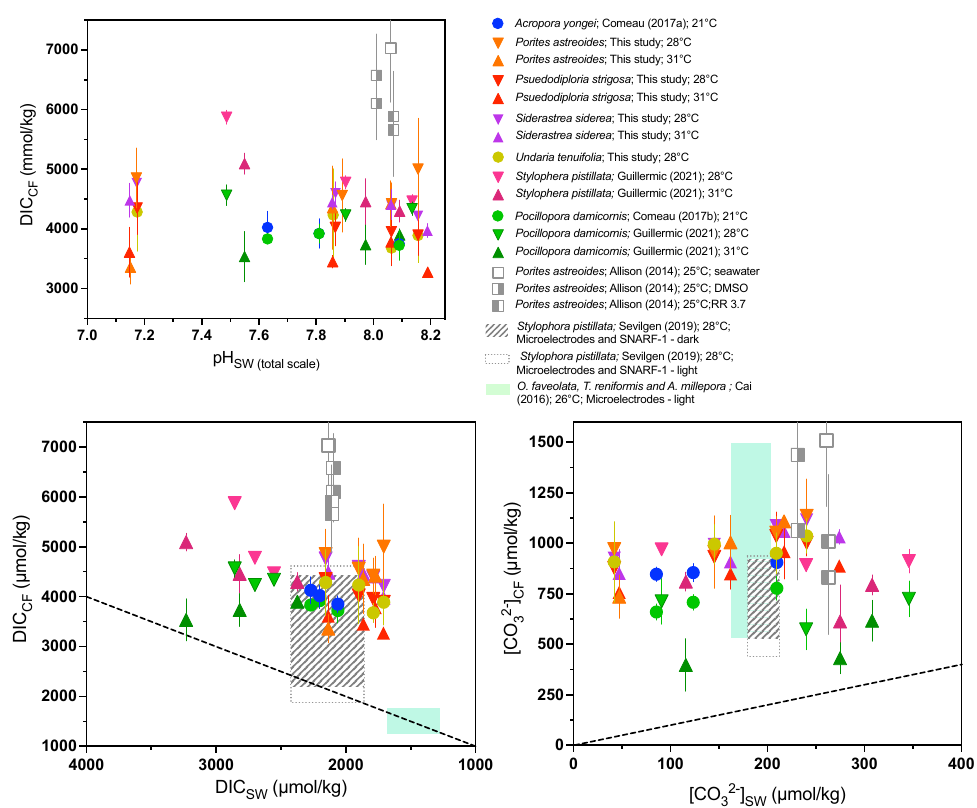
Figure 6. Compilation of combined δ 11 B and B/Ca-derived DIC CF and [CO 32 − ] CF measurements from available published data, as well as published microelectrode data. We include cultured shallow-water zooxanthellate corals, cold-water azooxanthellate corals, as well as a range of DIC CF values as determined by SNARF-1 pH-sensitive dyes and pH microelectrode analyses. ( A ) DIC CF as a function of pH SW (total scale), ( B ) DIC CF as a function of DIC SW , and ( C ) [CO 32 − ] CF as a function of [CO 32 − ] SW . ‘RR’ label denotes corals treated with the Ca-ATPase inhibitor ruthenium red [32]. Previously published data used in the figure are available in Table S12 alongside citations for data